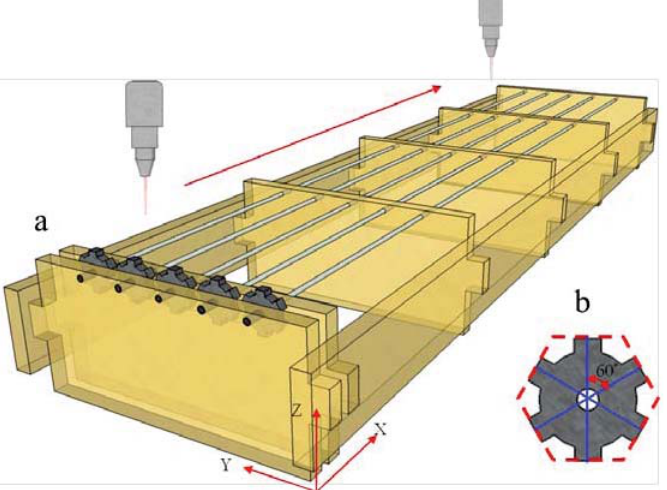
Figure 2. Schematic of the laser machining fixtures: ( a ) the processing fixture; and ( b ) the rotating and fixed optical fiber fixture.